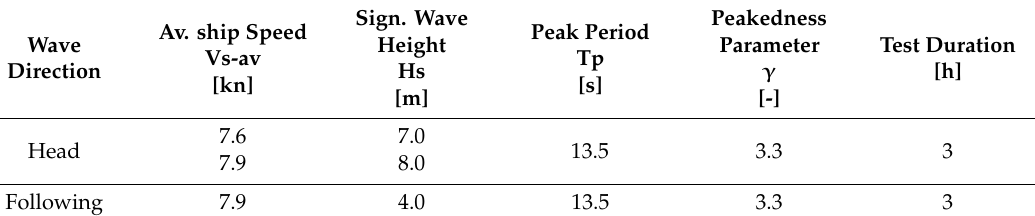
Table 4. Overview of tested wave conditions.